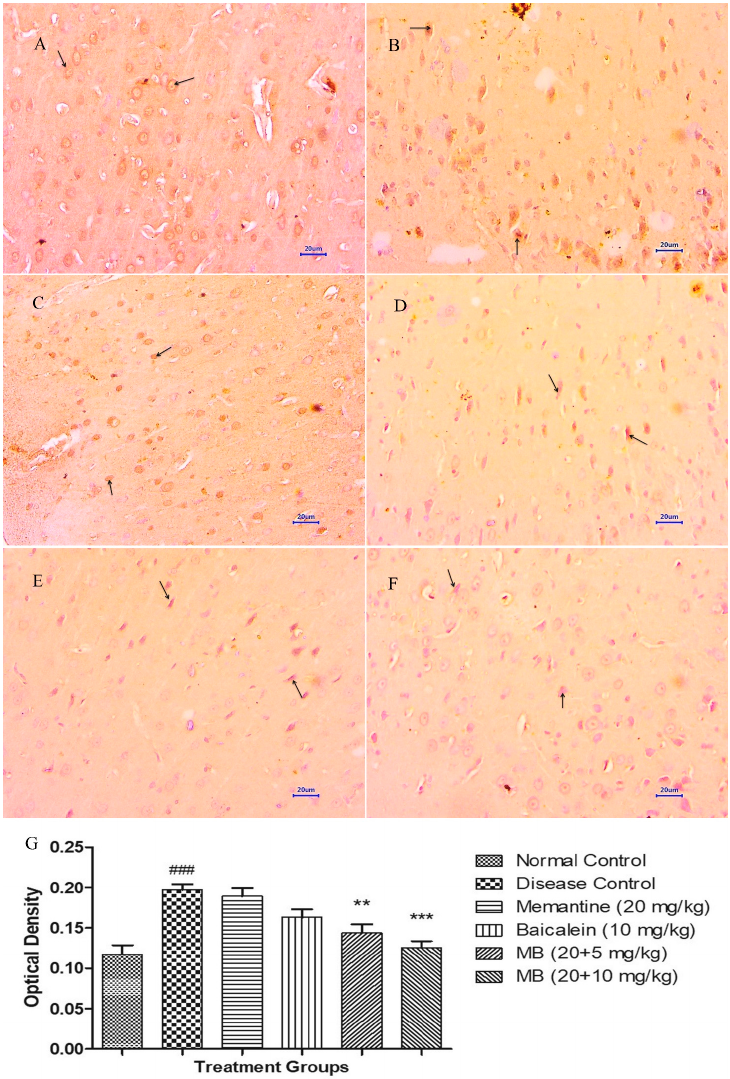
Figure 11. Effect of A β (1–42), baicalein and baicalein with memantine on β -amyloid expression in cortex (400 × ). ( A ) Normal control: displaying morphologically normal neuronal cells (arrow) in cortex. ( B ) Disease control: displaying moderate to severe β -amyloid deposition (arrow), exhibited by brown colouration in cortex. ( C ) Memantine 20 mg/kg: displaying mild to moderate β -amyloid deposition (arrow) exhibited by brown colouration in cortex. ( D ) Baicalein (10 mg/kg): displaying mild to moderate β -amyloid deposition (arrow) exhibited by brown colouration in cortex. ( E ) Memantine + Baicalein (20 + 5 mg/kg): displaying mild β -amyloid disposition (arrow) exhibited by brown colouration in cortex. ( F ) Memantine + Baicalein (20 + 10 mg/kg): displaying mild β -amyloid deposition (arrow) exhibited by brown colouration in cortex. ( G ) OD data for ICH. Data are represented as mean ± SEM, where ### p < 0.001 indicates comparison with normal control, whereas ** p < 0.01 and *** p < 0.001 indicates comparison with disease control group; SEM, Standard Error of Mean; MB: memantine + baicalein; IHC: Immunohistochemistry.